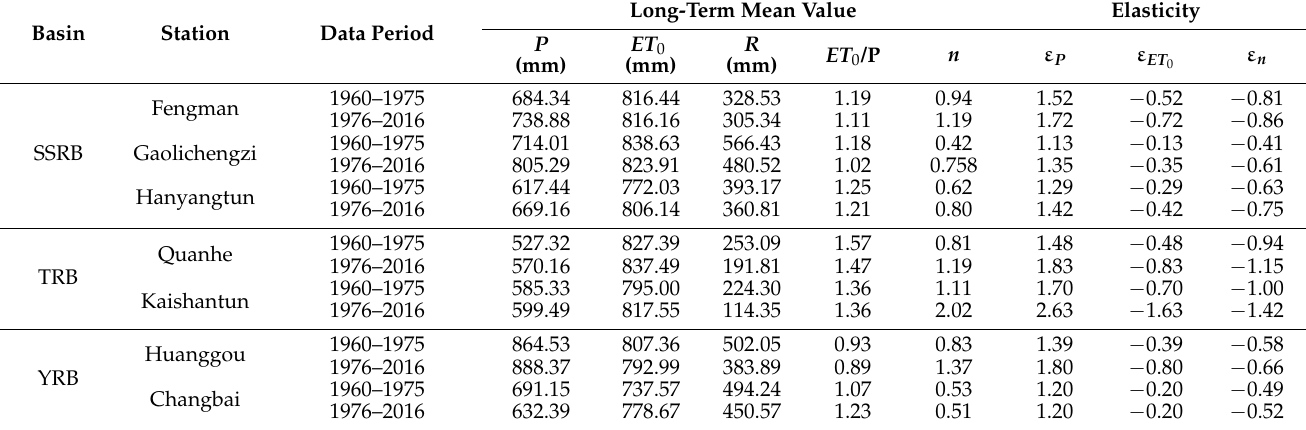
Table 3. Hydroclimatic characteristics of the base and impact